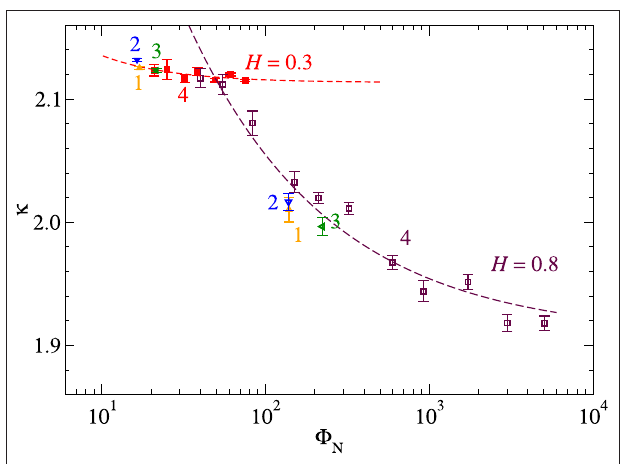
FIGURE 6 | Proportionality coefficient κ as a function of the Nayak parameter 8 N 1.5 8 6 at p ∗ 0.02. Full and open symbols relate to H = = H 0.8, respectively. Different surface realizations were considered: (1) orange = triangles up: cut-off, (2) blue triangles down: smooth roll-off, (3) green triangles left: hard roll-off. In these three cases, ε t and ε f were fixed: ε t ε f 1 / 125, Finally, (4) squares: cut-off with 1 / 40 = c 8 − ν N , where ν turned out to be consistent with ν κ lines are fits κ = ∞ + for H 0.8 and ν 1 for H 0.3. = ≈ =